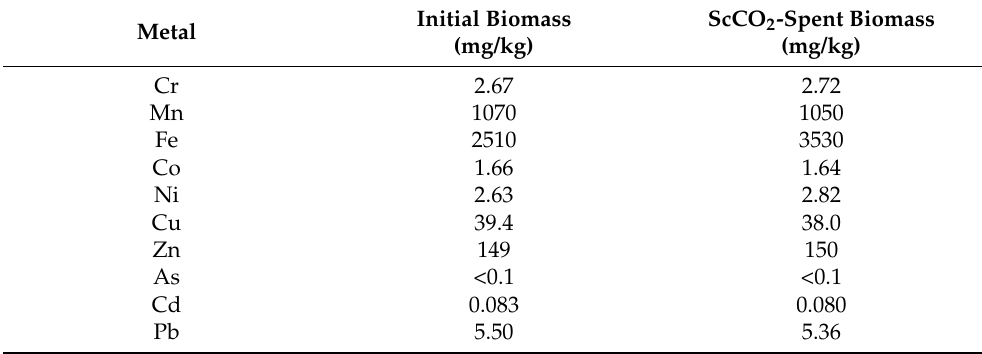
Table 3. Metal composition of Tetradesmus obliquus biomass: initial biomass and biomass after supercritical CO 2 extraction (ScCO 2 -spent